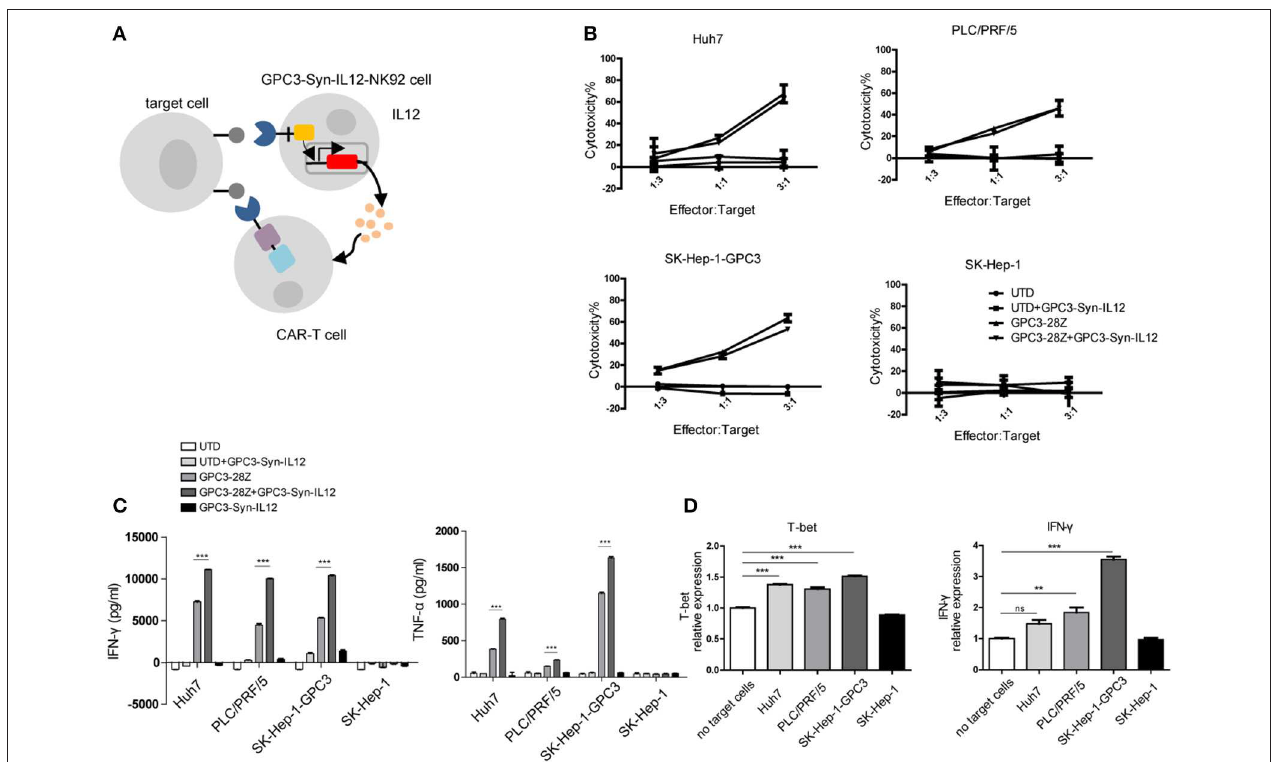
FIGURE 3 | In vitro activities of CAR T cells in the presence of GPC3-syn-IL12-NK92 cells. (A) NK92 cells were engineered with the α -GPC3 synNotch controlling the expression of IL12 in response to GPC3 antigen on the tumor surface. The IL12 secretion effect on GPC3-28Z CAR T cells may influence antitumor ability. (B) The effector cells (GPC3-28Z CAR T) were co-cultured for 12h with target cells (1 × 10 4 ) at E:F ratios of 3:1, 1:1, and 1:3 in a total volume of 100 µ l, and GPC3-Syn-IL12 NK92 cells were the same as GPC3-28Z CAR T cells. Cell lysis was determined by an LDH release assay. (C) IFN- γ and TNF- α production by GPC3-28z CAR T and GPC3-Syn-IL12 NK92 cells co-cultured with the indicated HCC cell lines at an E:F ratio of 1:1 for 24h. (D) The expression of T-bet and IFN- γ mRNA in GPC3-28Z CAR T cells by qPCR. Using a 3- µ m pore size in 12-well transwell chambers, GPC3-Syn-IL12 NK92 cells were stimulated with different HCC cell lines to secrete IL12 in the upper chambers, and GPC3-28Z CAR T cells were plated in the lower chambers. After 24h, GPC3-28Z CAR T cells were collected, and total RNA extracted from GPC3-28Z CAR T cells was reverse transcribed and amplified using primers specific for T-bet and IFN- γ . Each experiment was repeated at least twice with similar results. Data are presented as the mean ± SEM, and significant differences between groups were measured by using one-way analysis of variance (ANOVA). ** P < 0.01, *** P < 0.001. Only significant differences are